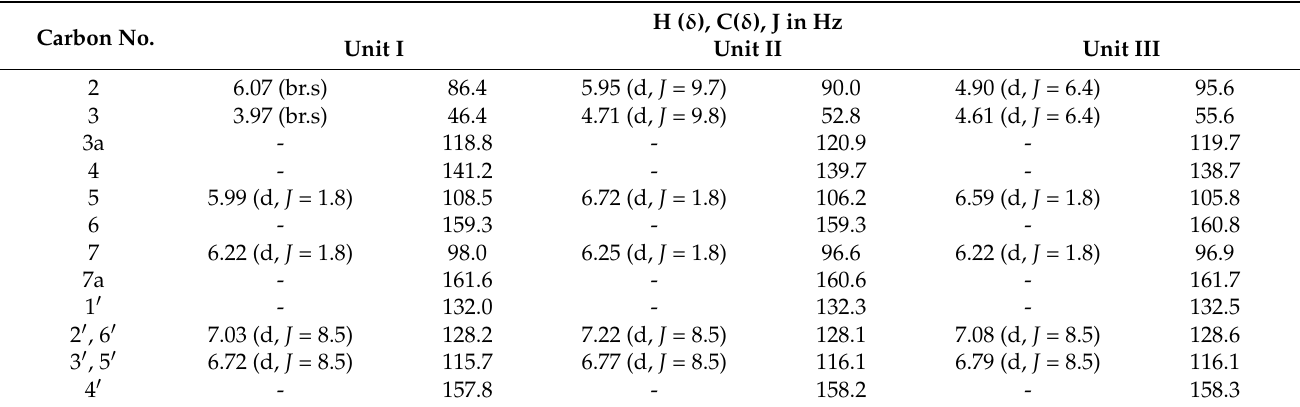
Table 2. The 13 C and 1 H-NMR spectral data for α